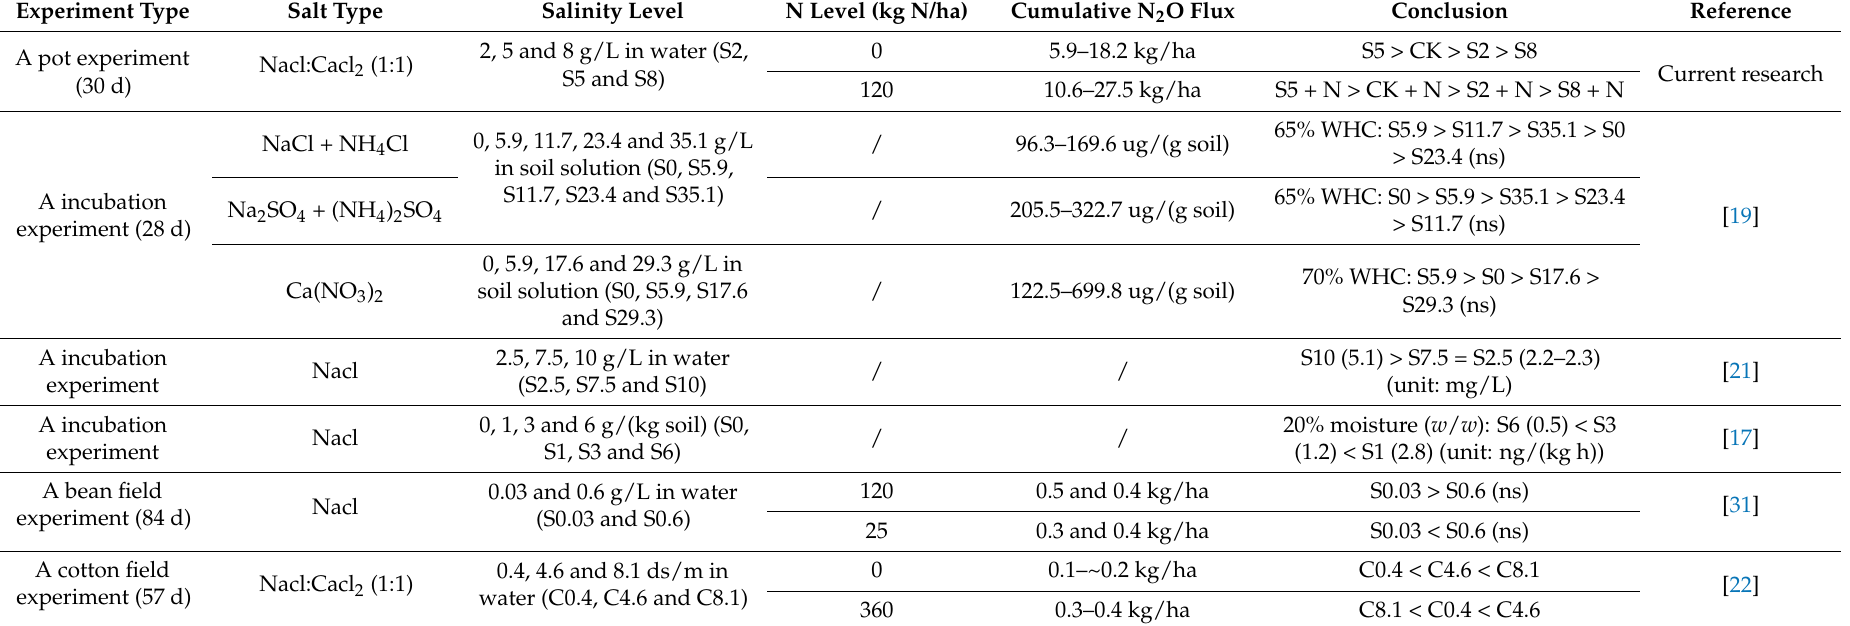
Table 5. Summary of results of the effect of salinity on N 2 O